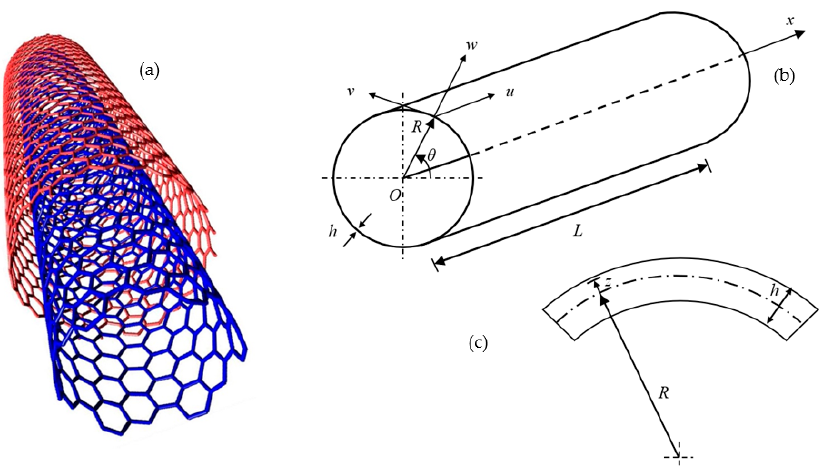
Figure 1. Continuum modelling of a DWCNT. ( a ) Actual discrete DWCNT; ( b ) geometry of the equivalent continuous thin circular cylindrical shell; ( c ) cross-section of the surface of the equivalent continuous shell.